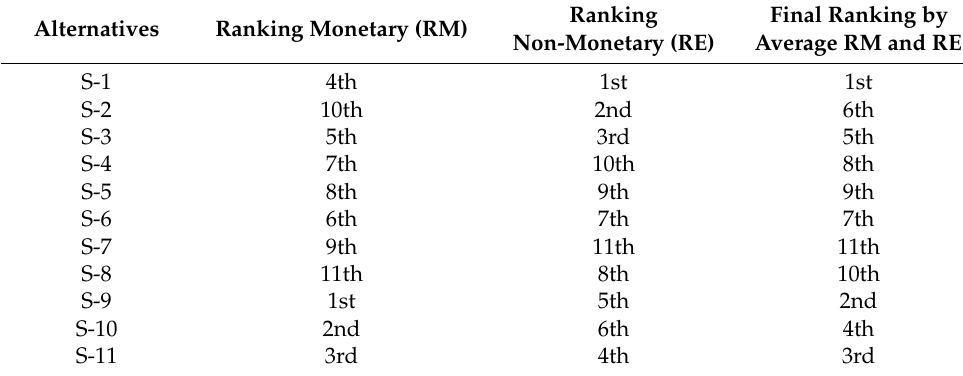
Table 7. Aggregated Ranking for Chemical